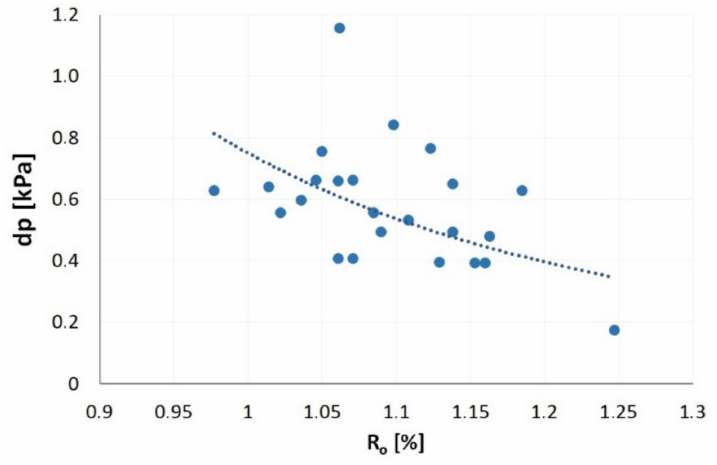
Figure 11. The influence of coalification degree on the value of desorption intensity